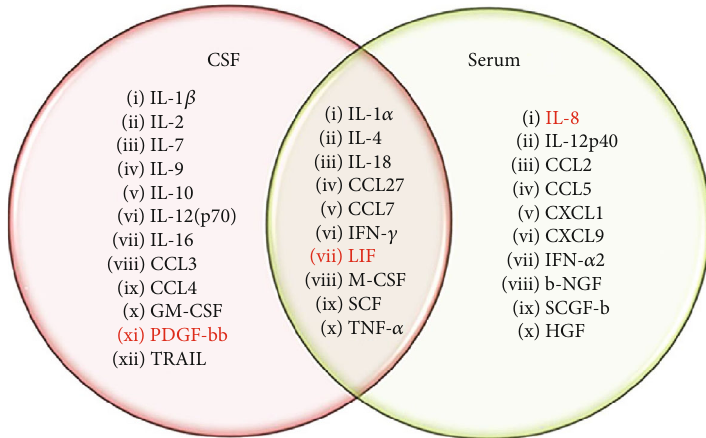
Figure 2: Cytokines expressed uniquely and commonly in serum and CSF of MS as compared to non-MS controls. Red highlighted cytokines are downregulated in patients as compared to control. The rest of the cytokines are upregulated in patients. Controls